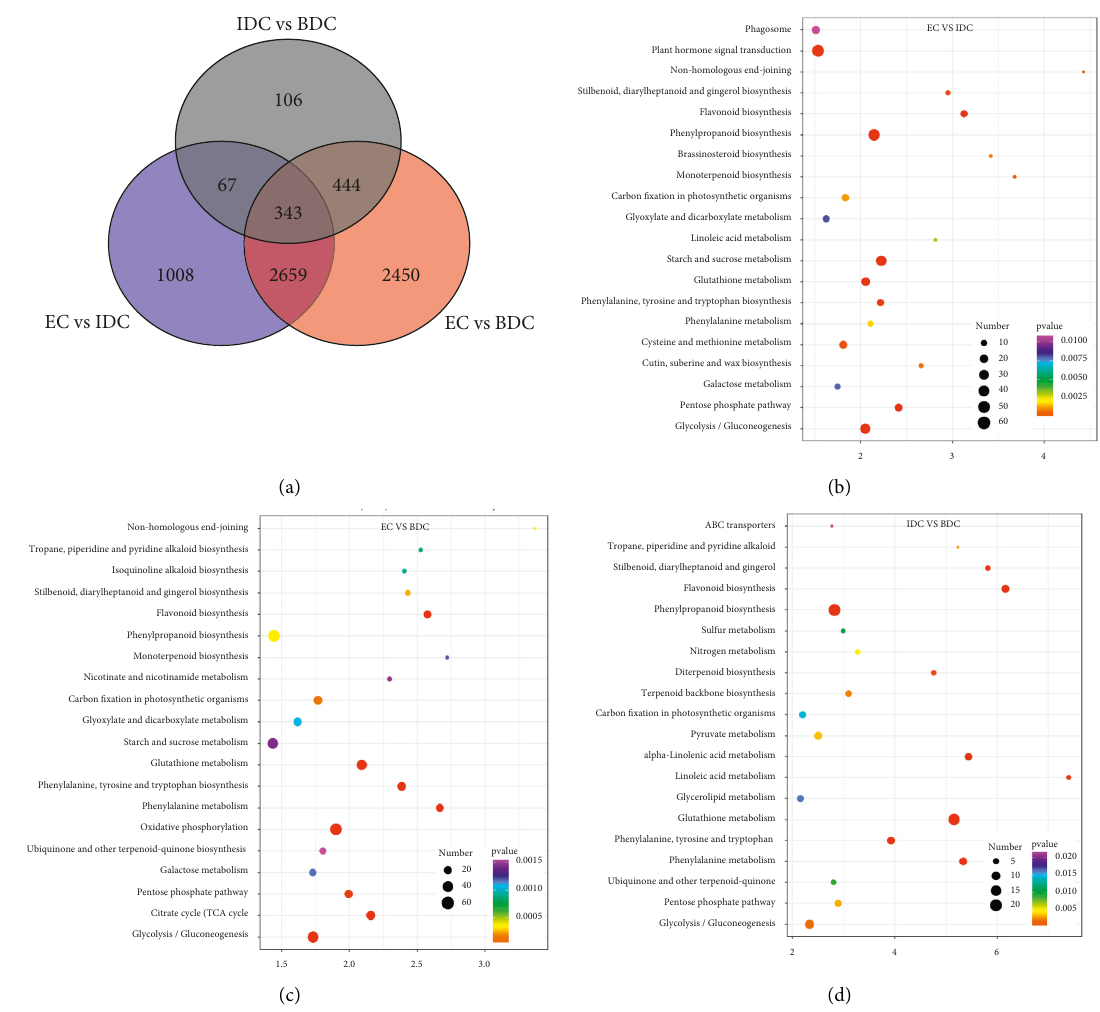
Figure 5: Functional analysis of DEGs among callus in different induction states. (a) Venn diagram of DEGs in three different states of callus. (b) KEGG analysis of DEGs between EC and IDC. The bubble map shows the KEGG enriched pathway. The larger the bubble, the more the genes; the darker the bubble color, the higher the Q-value of the DEGs. (c) KEGG analysis of DEGs between EC and BDC. (d) KEGG analysis of DEGs between IDC and